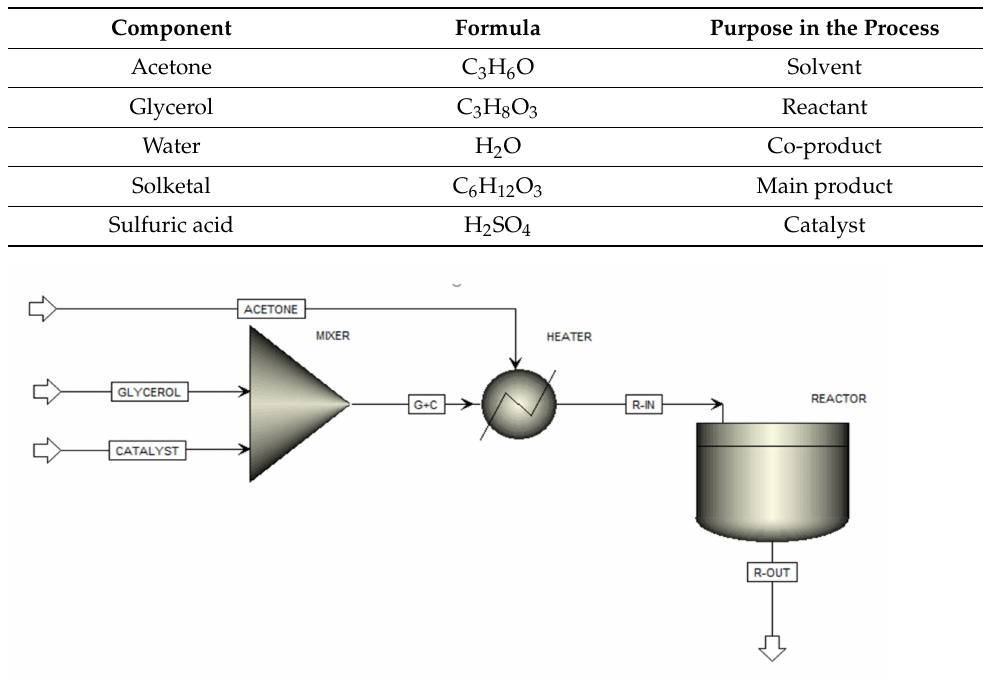
Table 2. Components list for simulation on Aspen Plus simulator.